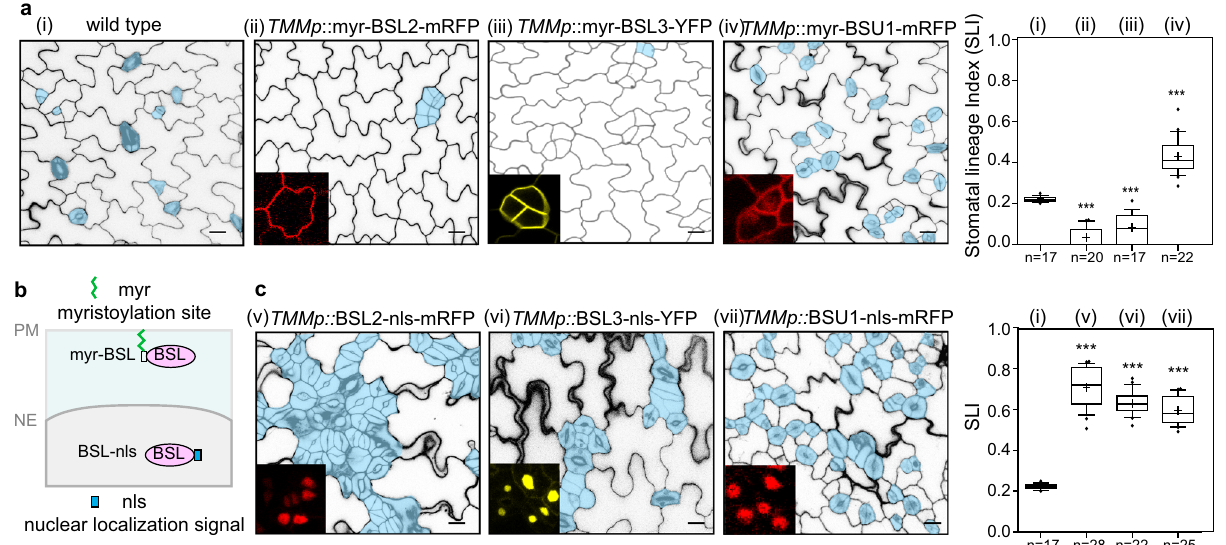
Fig. 3 Opposite regulation of BSL proteins at the PM vs. in the nucleus. a Stomatal phenotypes in 5-dpg adaxial cotyledon epidermis overexpressing myristoylated (myr) BSL proteins (driven by the TMM promoter). Stomatal lineage cells are manually traced (blue). Insets (red and yellow) show protein localization in stomatal lineage cells. Note, myr-BSL2/BSL3 were solely found at the plasma membrane and myr-BSU1 was localized to the PM, cytoplasm, and nucleus. Each representative confocal images were selected from at least 10 individual cotyledons. Scale bar, 20 μ m. b Schematic diagram depicts engineered BSL proteins for functional testing at the PM (myr-BSL) or in the nucleus (BSL-nls). PM, plasma membrane; NE, nuclear envelope. c Stomatal phenotypes in 5-dpg adaxial cotyledon epidermis overexpressing nuclear BSL-nls proteins (driven by the TMM promoter). Insets (red and yellow) show protein localization in the nucleus. Box plots in a and c show the fi rst and third quartiles, split by the median (line) and mean (cross). n , number of biologically independent cotyledons from two homozygous transgenic lines (T3). Statistical analysis was performed to compare with the wild-type values. Unpaired t -test, *** P < 0.0001. Exact P values are 6.65262 e − 15 for i vs . ii, 1.19704 e − 7 for i vs . iii, 9.91101 e − 11 for i vs . iv, 6.4315 e − 21 for i vs . v, 1.70435 e − 21 for i vs . vi, 5.90558 e − 21 for i vs .